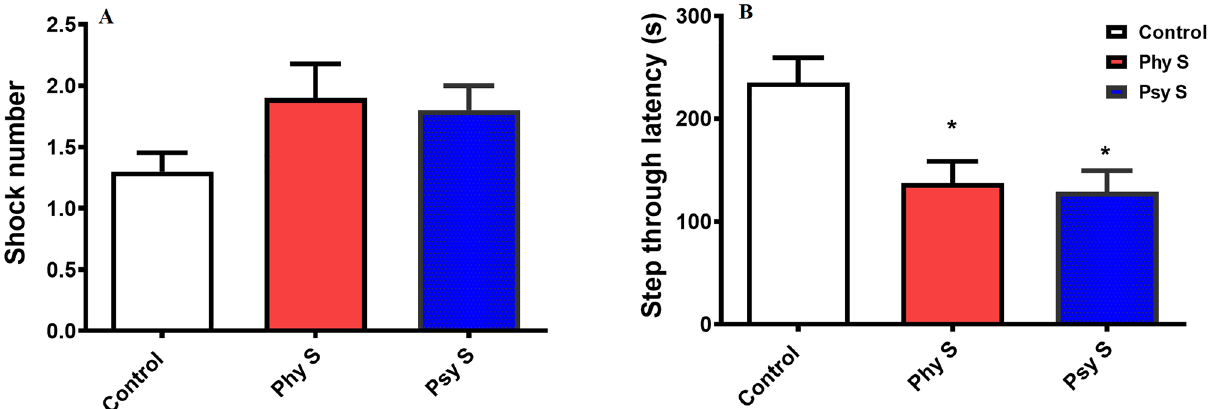
Figure 4. The effect of PS on passive avoidance learning and memory of the offspring. ( A ) Number of shocks required for learning. ( B ) Step through latency. Data are displayed as Mean ± SEM. Phy s: physical stress, Psy s: psychological stress, * ( p < 0.05) compared to the control group.